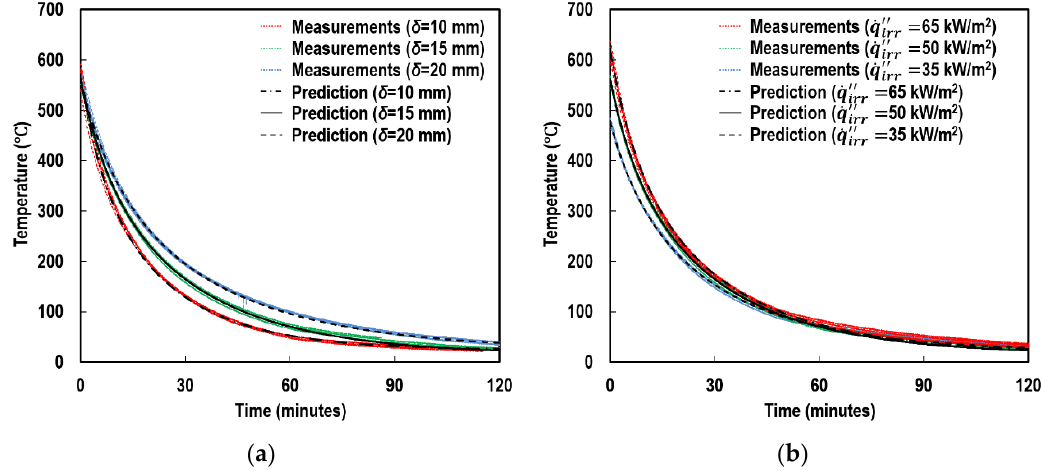
. = 50 kW / m 2 and ( b ) δ = 15 q (cid:48)(cid:48) irr